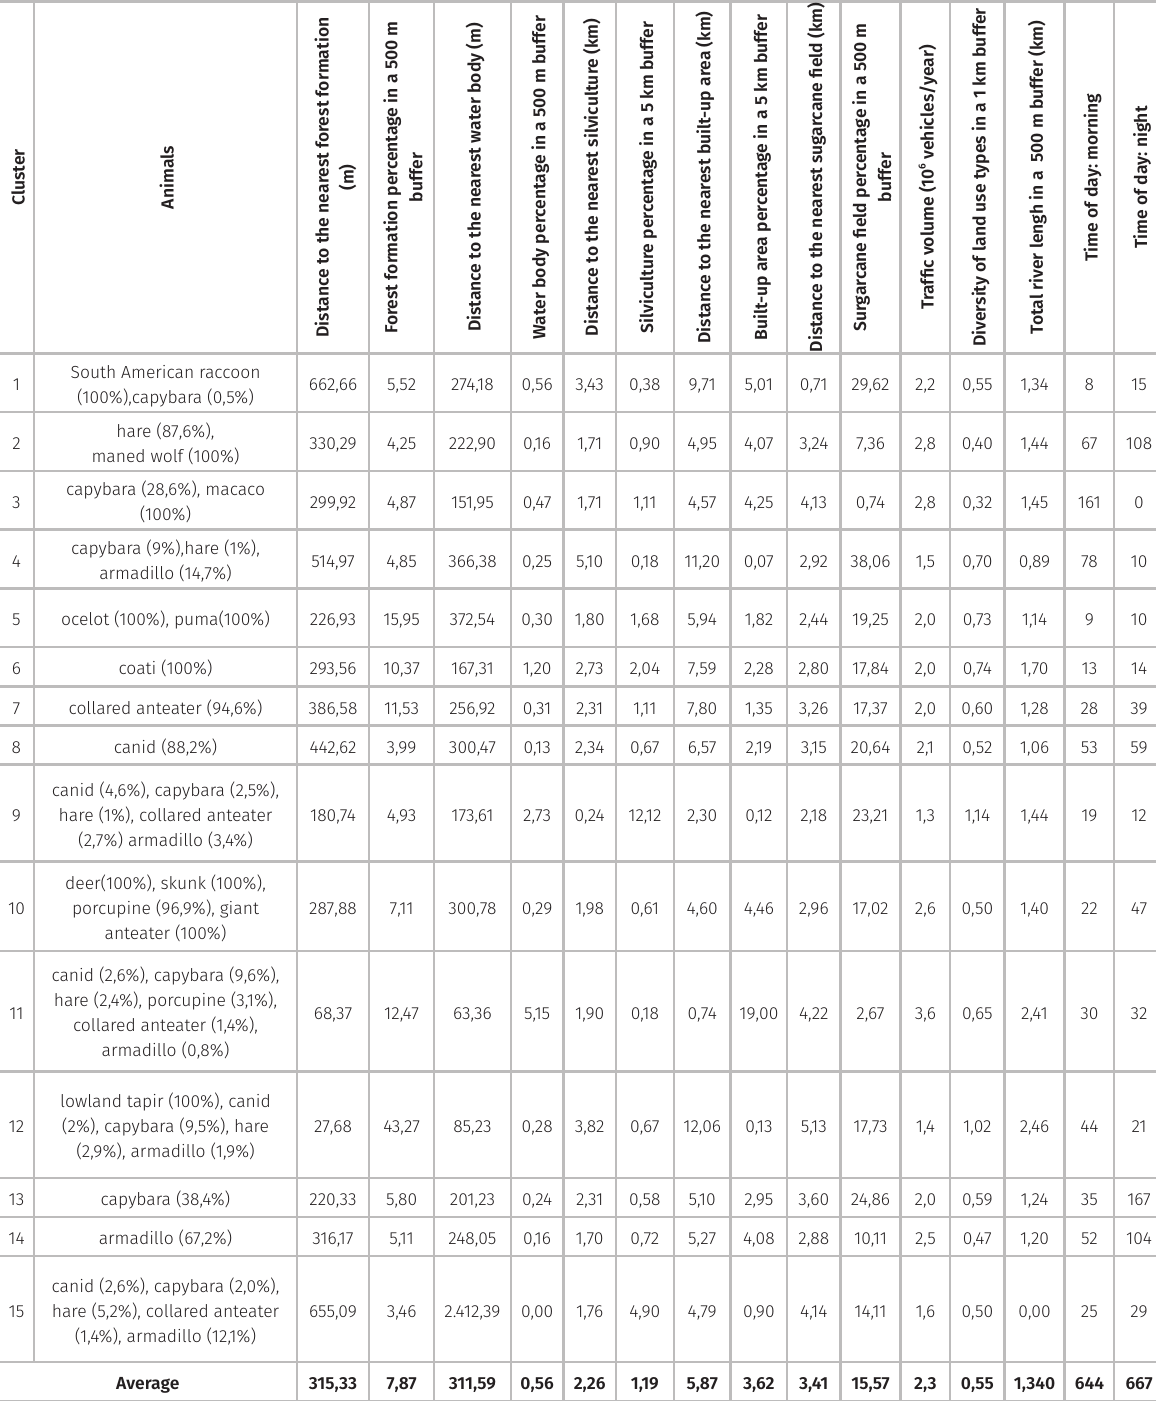
Table V. Averages for distances to different types of land cover and highway characterization, per cluster, in the definitive analysis of the self-ordering map.